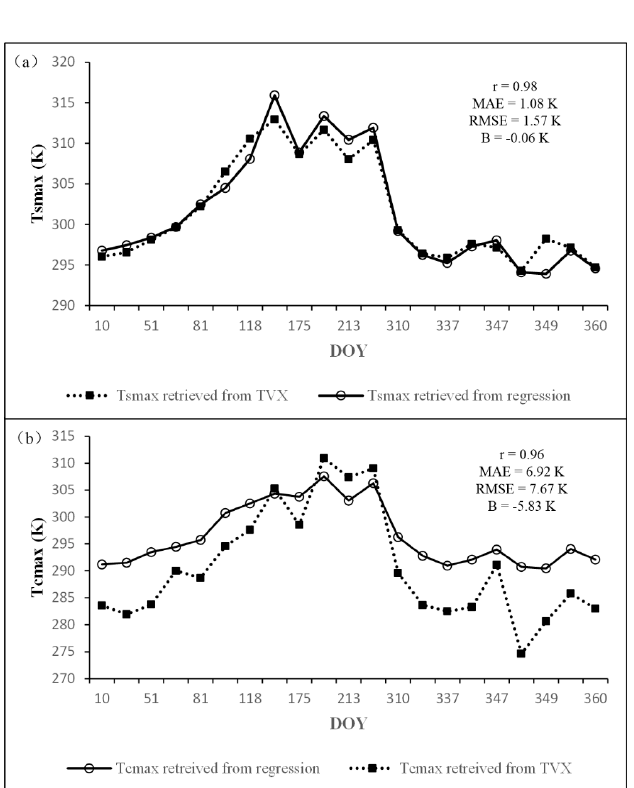
Figure 12. Comparison of T smax determined by the TVX method and regression approach ( a ), and comparison of T cmax determined by the TVX method and regression approach ( b ).